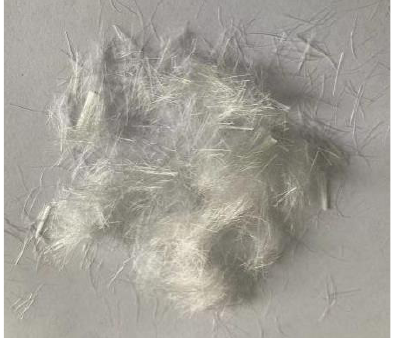
Figure 1. Polypropylene fibers. Table 1. Physical and mechanical properties of polypropylene fiber.